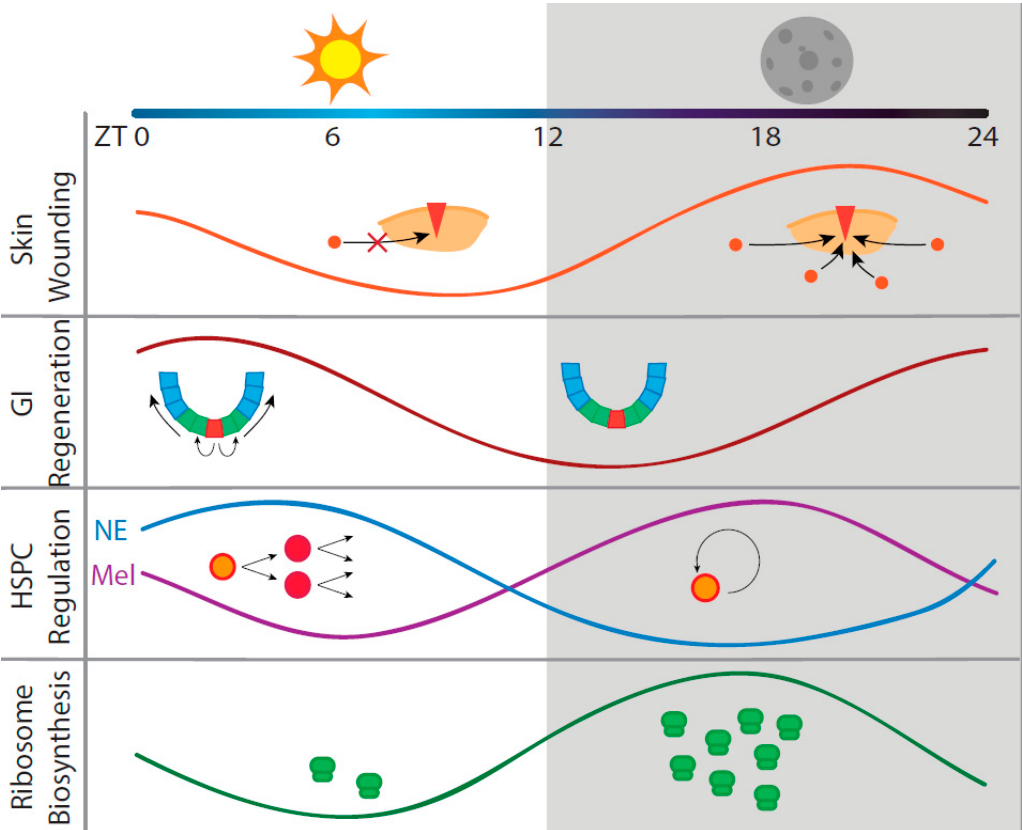
Figure 1. Examples of circadian interactions in regenerating systems. Circadian rhythms have been shown to impart diurnal di ff erences in regeneration in several mouse tissue types. In skin, fibroblast migration to the site of wounding is under circadian regulation and controls wound healing e ffi ciency [27]. In intestines, mitotic activity of intestinal crypt cells during GI damage-induced regeneration is under circadian control [28]. HSPC di ff erentiation versus self-renewal signals are regulated by central clock norepinephrine (NE) and melatonin (Mel) secretion [29]. An understudied mechanism that may contribute to di ff erences in a global regenerative state is fluctuations in ribosome biogenesis, which displays diurnal rhythmicity [30]. Diagrams are not drawn to scale and are meant to show general